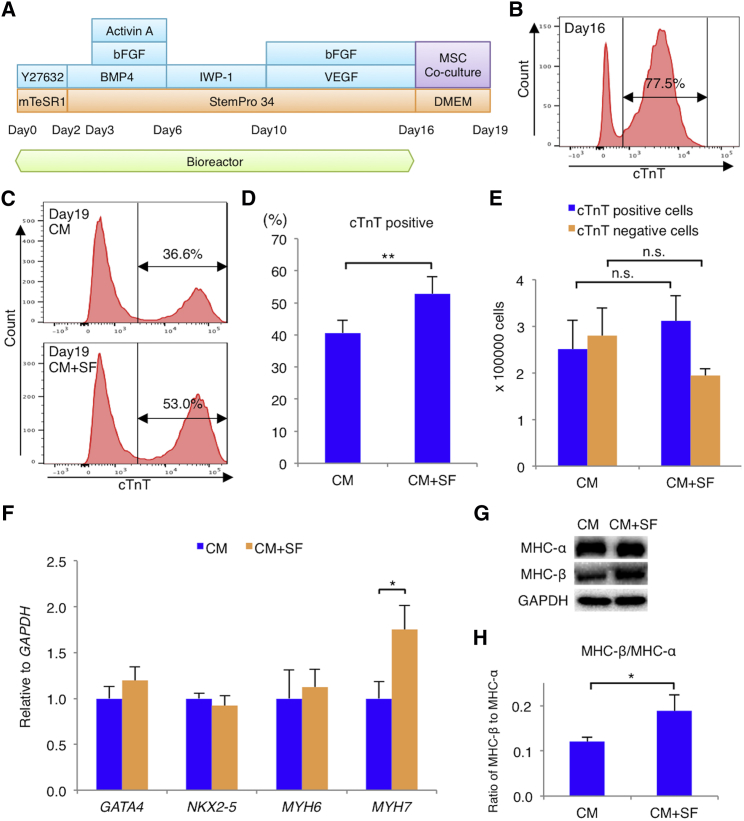
Human Mesenchymal Stem Cells Increase the Population of Cardiac Troponin T-Positive Cells and Promote the Molecular Development of Cardiomyocytes Derived from Human Induced Pluripotent Stem Cells(A) Cardiomyogenic differentiation protocol and co-culture with human mesenchymal stem cells (hMSCs). (B) Representative flow cytometry data of differentiated human induced pluripotent stem cells (hiPSC-CMs) stained with anti-cardiac troponin T (cTnT) antibodies at day 16. (C) Representative flow cytometry data of differentiated hiPSC-CMs with and without hMSC-derived soluble factors stained with anti-cTnT antibodies at day 19 (CM+SF and CM, respectively). (D) Percentage of cTnT-positive cells in the CM and CM+SF groups as determined by flow cytometry (n = 5 for each group). **p < 0.01, Student t test. (E) Number of cTnT-positive or -negative cells in the CM and CM+SF groups (n = 3 for each group). n.s., not significant, Student t test. (F) Expression of cardiac cell-specific genes (GATA binding protein 4 [GATA4], NK2 homeobox 5 [NKX2-5], and myosin heavy chain 6 [MYH6] and MYH7) in CM or CM+SF cells, normalized against GAPDH expression (n = 7 for each group). *p < 0.05, Student t test. (G) Western blot of CM or CM+SF cells using anti-myosin heavy chain alpha (MHC-α) antibody, anti-MHC-β antibody, and anti-GAPDH antibodies. (H) Ratio of MHC-β to MHC-α in CM or CM+SF cells as determined by western blotting (n = 4 for each group). *p < 0.05, Student t test. For all experiments, results are shown as mean + SEM. bFGF, basic fibroblast growth factor; BMP4, bone morphogenetic protein 4; VEGF, vascular endothelial growth factor.